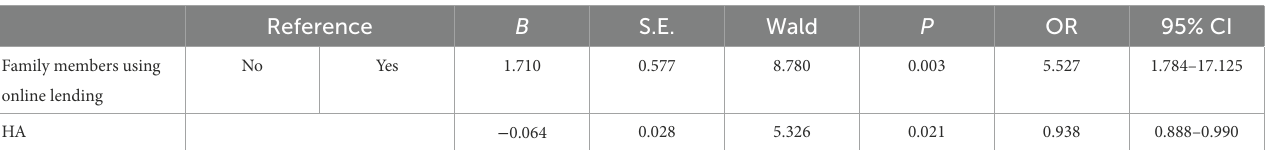
TABLE 4 Binary logistic regression of online lending for